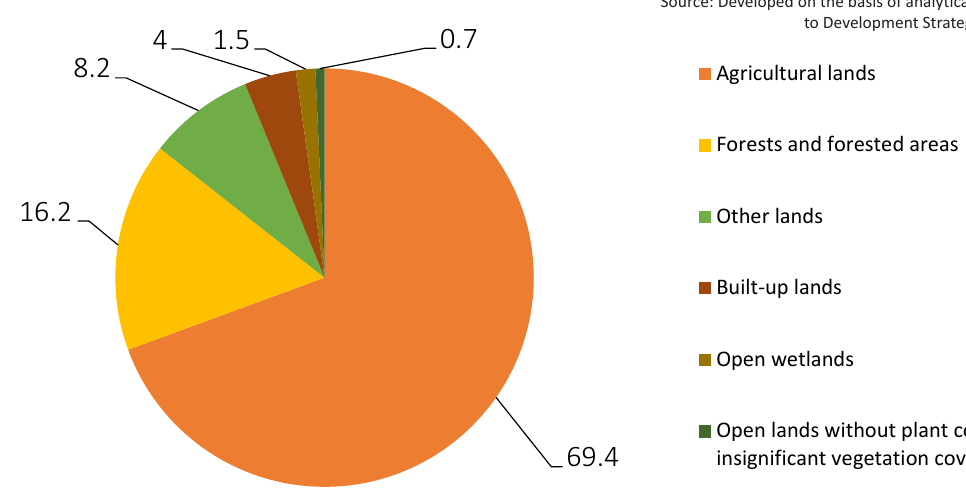
Figure 3. Structure of the land fund of Cherkasy region